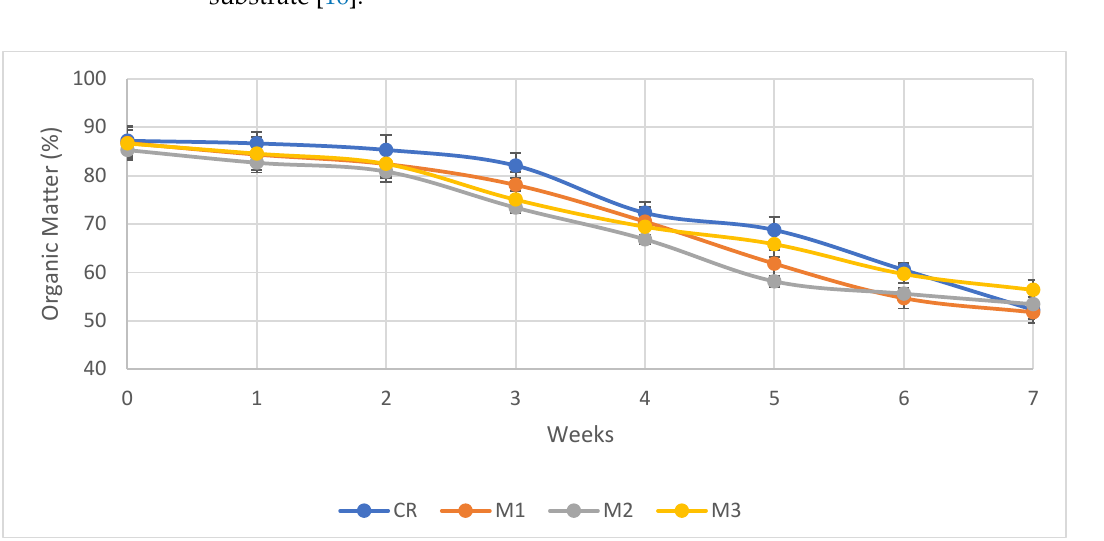
Figure 9. Organic matter behavior in mixtures (CR, M1, M2 and M3) during the vermicomposting process.